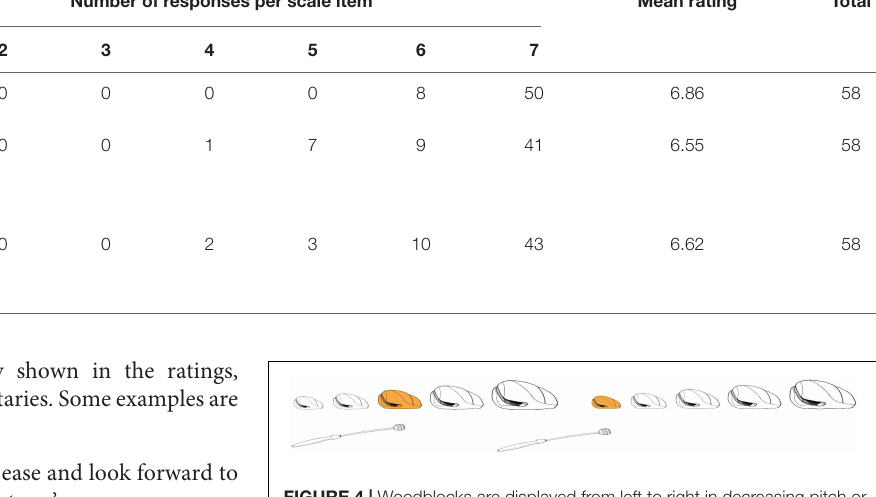
FIGURE 4 | Woodblocks are displayed from left to right in decreasing pitch or increasing size. The highlighted size of the woodblock changes each time the picture is displayed, inviting the participant to explore different (apical alveolar) clicking sounds and different pitches achieved by adjusting the tongue movement and mouth